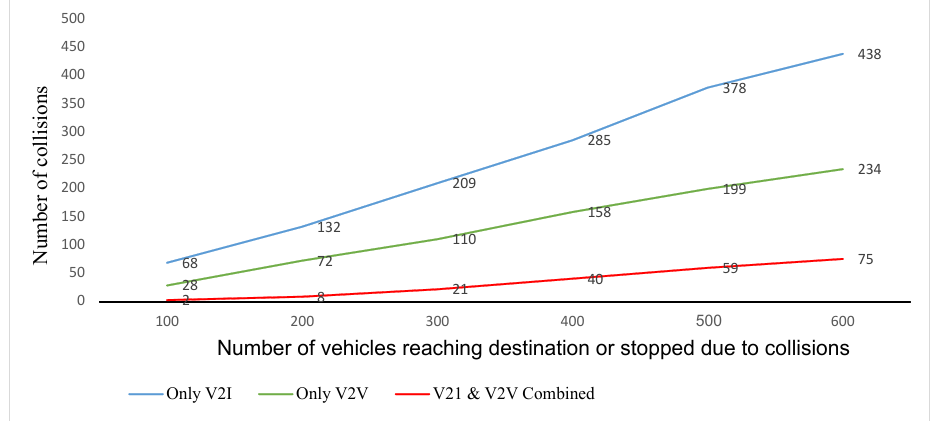
Figure 8. Graph of collisions for V2V, V2I, and V2V and V2I